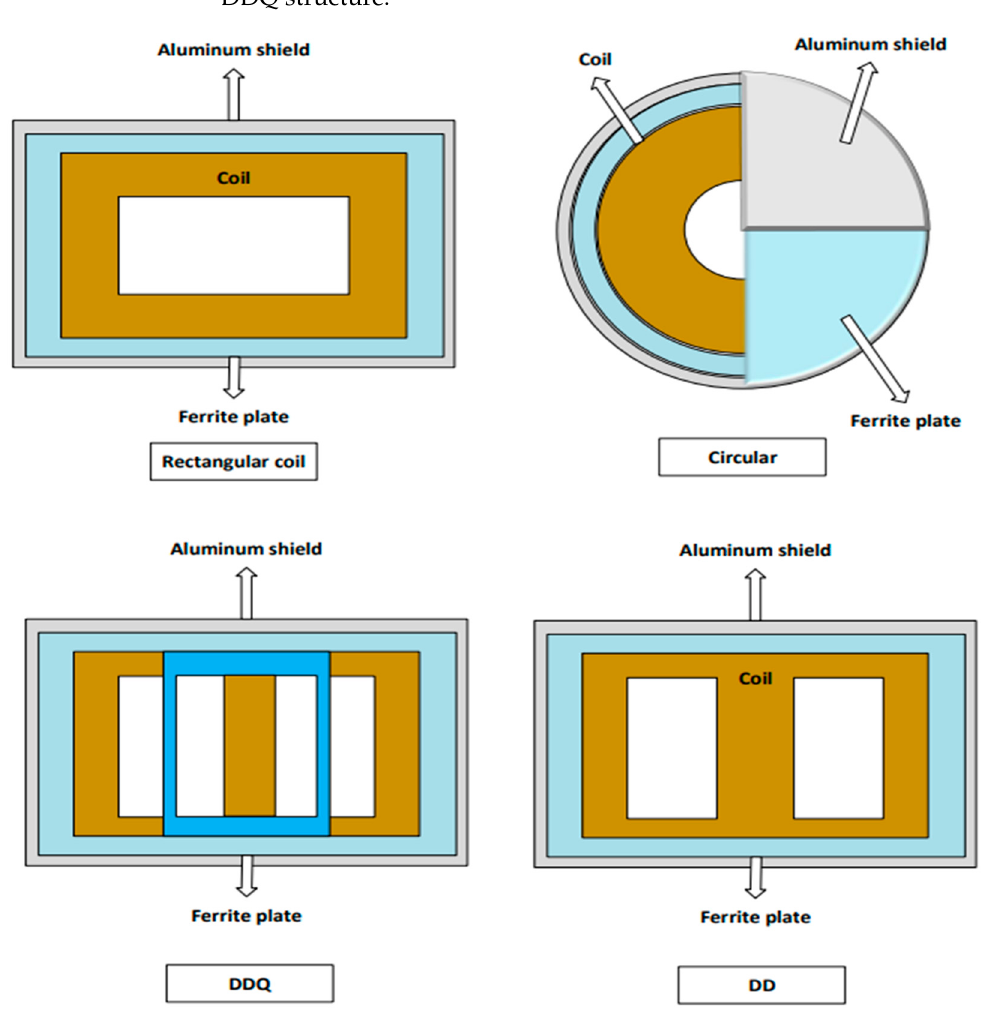
Figure 17. Coil structures.